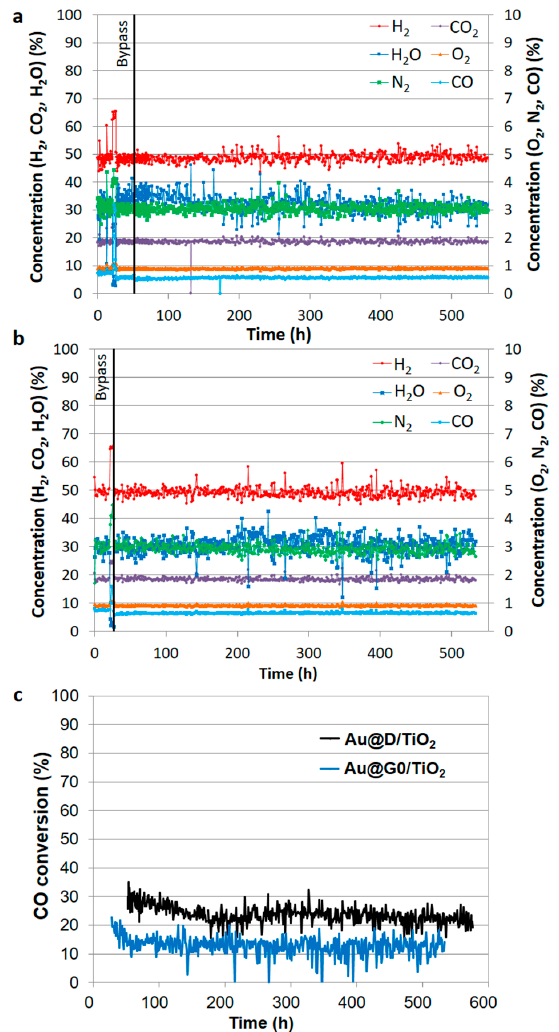
Figure 9. Long-term stability test performed at 453 K. Species detected at the outlet of ( a ) Au@D/TiO 2 and ( b ) Au@G0/TiO 2 . ( c ) CO conversion for both microreactors. The concentration of the inlet mixture was measured for 20 h, which is the period marked as bypass.